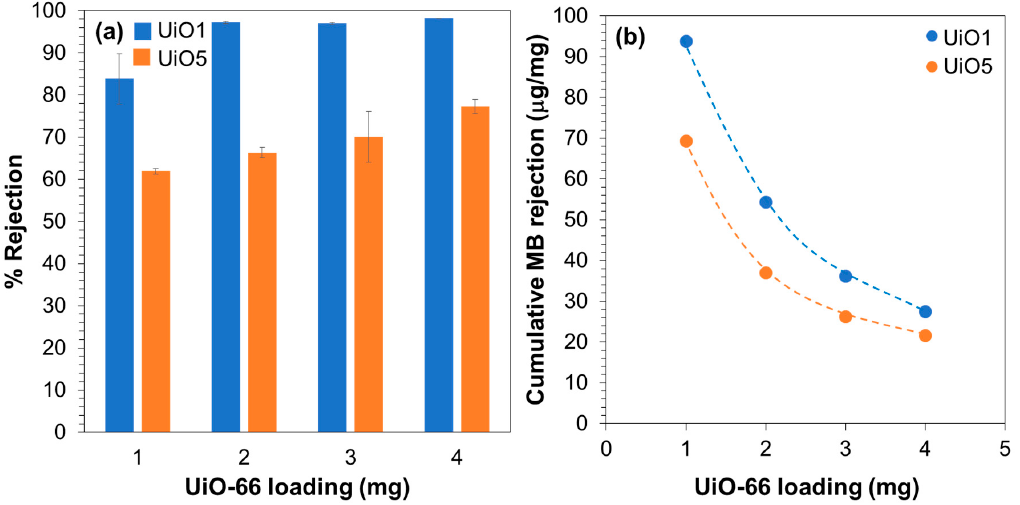
Figure 7. ( a ) Cumulative rejection for the filtration of 350 mL of the MB aqueous solution; ( b ) cumulative amount of MB rejected per loading.